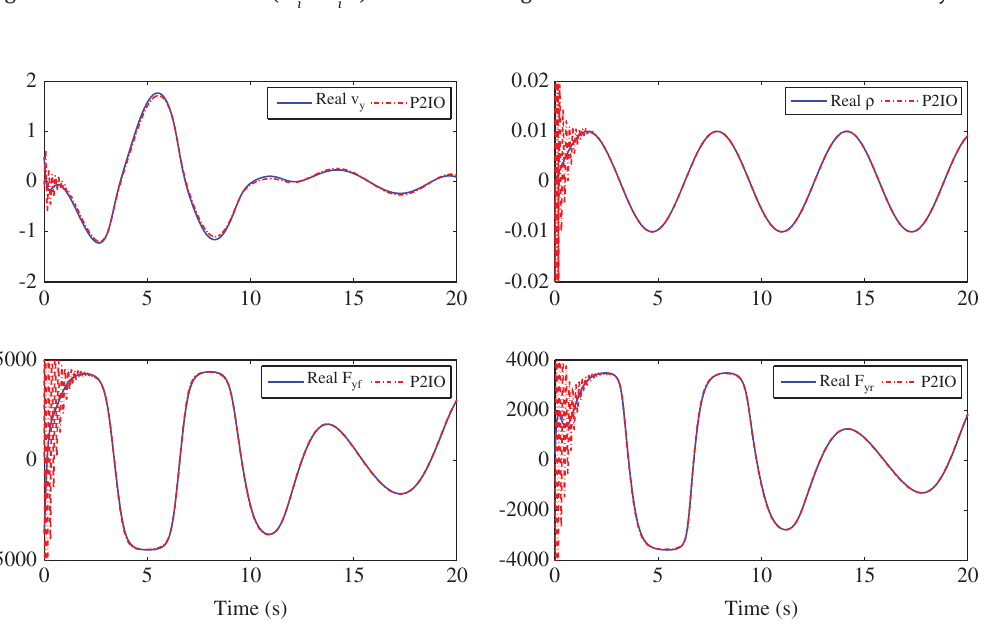
Figure 4. Actual State and Unknown Inputs vs. Estimated